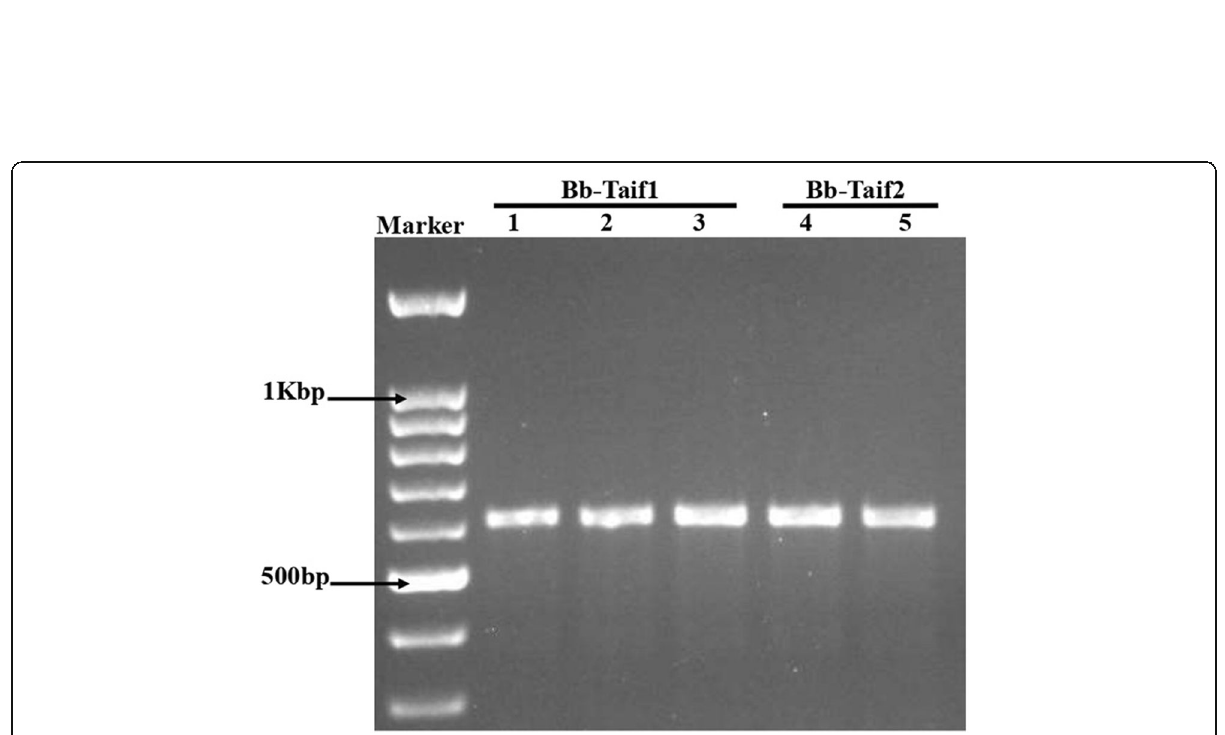
Fig. 2 PCR products of ITS genes in five endophytic specimens of Beauveria bassiana isolated from grape at Taif, KSA (3 specimens for Bb-Taif1 isolate and 2 specimens for